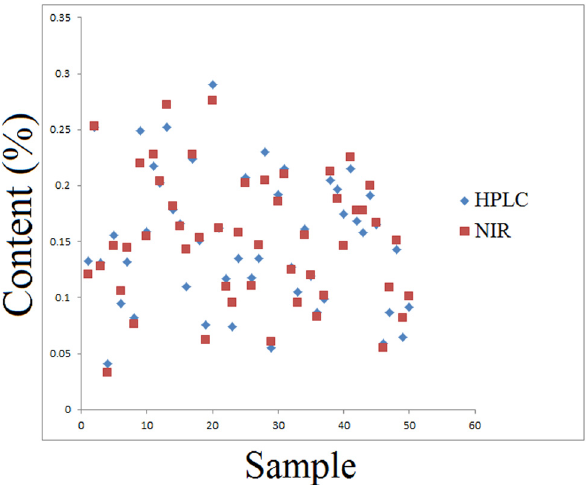
Figure 9: The reliability evaluation of NIR method versus HPLC method was used to calculate the student ’ s t - test ( α = 0.05 ) for paired